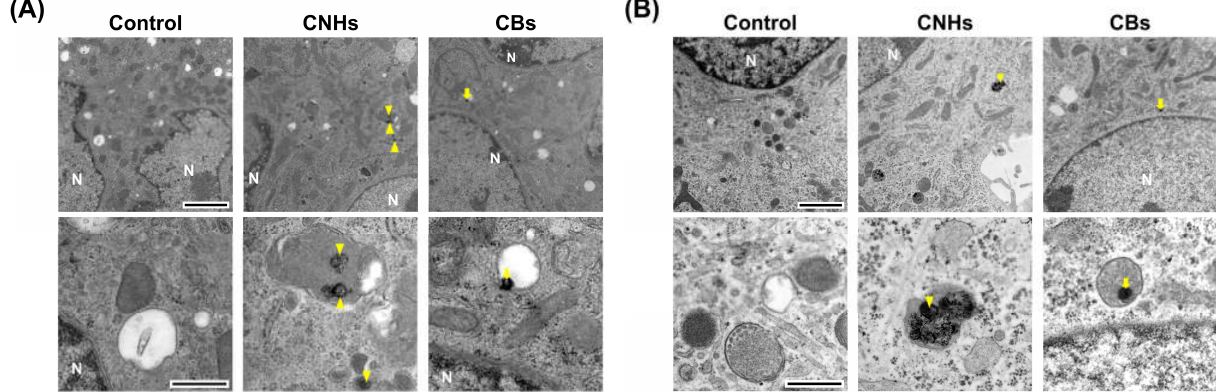
Figure 2. Intracellular uptake of CNMs into OCs and OBs. ( A ) Intracellular uptake of CNHs and CBs in OCs. The cultures were exposed to CNHs and CBs for 24 h. Control cultures were exposed to dispersants without CNMs. ( B ) Intracellular uptake of CNHs and CBs in OBs. The cultures were exposed to CNHs and CBs for 24 h. Control cultures were exposed to dispersants without CNMs. The cells were stained with nuclear staining (blue) and lysosomal staining (red), and phase-contrasted-merged images are shown. High magnification images are shown in the lower panels. Arrows and arrowheads indicate intracellular CNHs and CBs, respectively. Scale bars: 50 µm ( upper panels in A and B) and 20 µm ( lower panels in A and B).